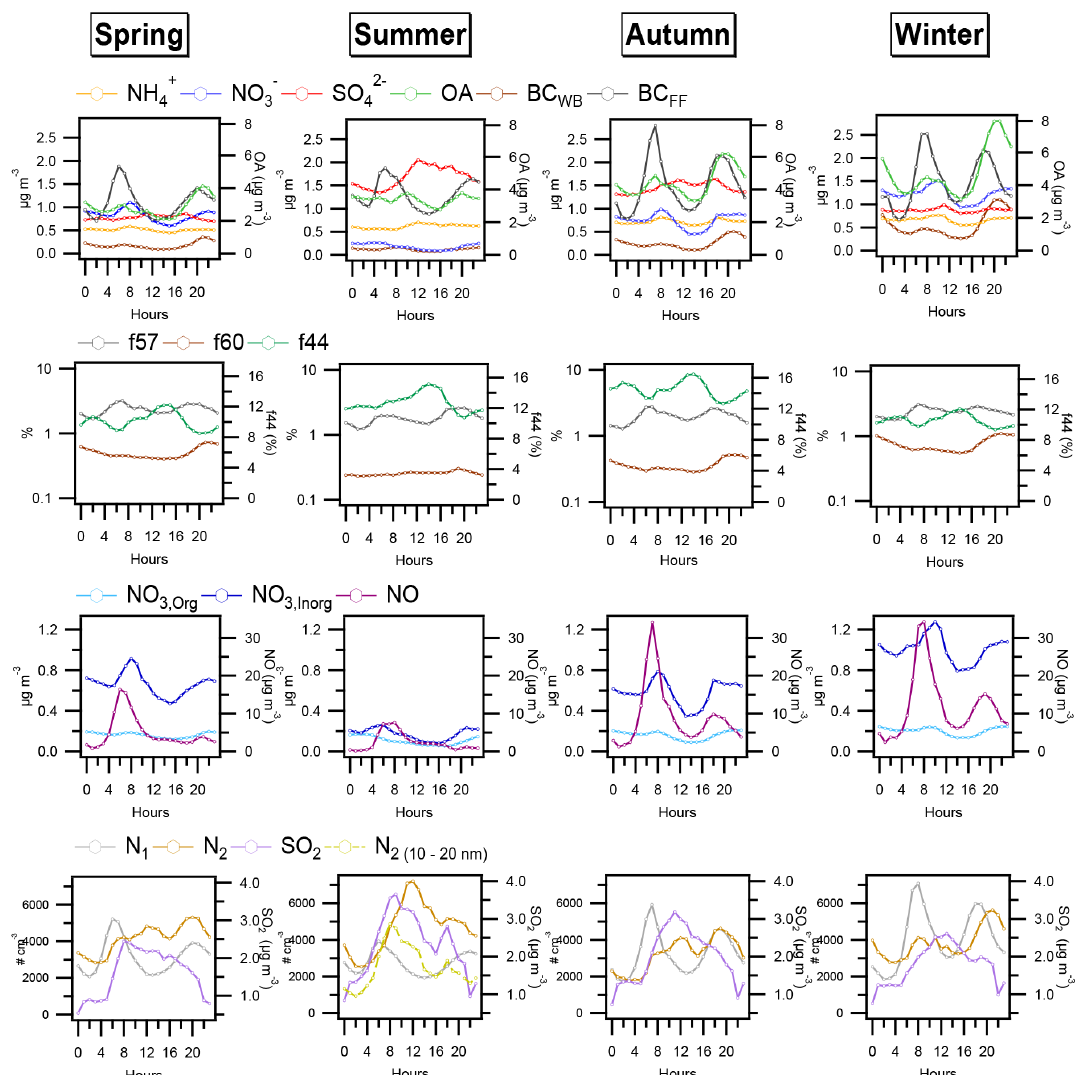
Figure 6. Seasonal diurnal profiles of PM 1 species, specific fractions of organic fragments ( f 60 , f 44 and f 57 ), nitrate components (NO 3 , Org , NO 3 , Inorg ) and NO, and UFP components ( N 1 , N 2 ) and SO 2 . Note that the left axis for f 60 and f 57 values is on a logarithm scale for clarity reasons. For summer, a secondary number of particles N 2 was also calculated for N between 10 and 20nm from SMPS GRIMM measurements during the 23 June–12 August 2017 period (yellow dashed